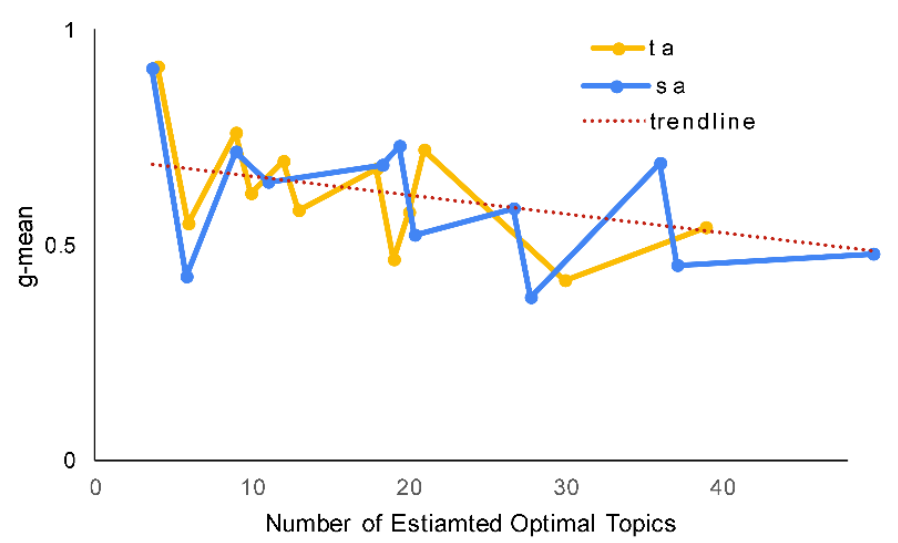
Figure 9. Performance of the two best models with respect to the number of requirements in an SRS